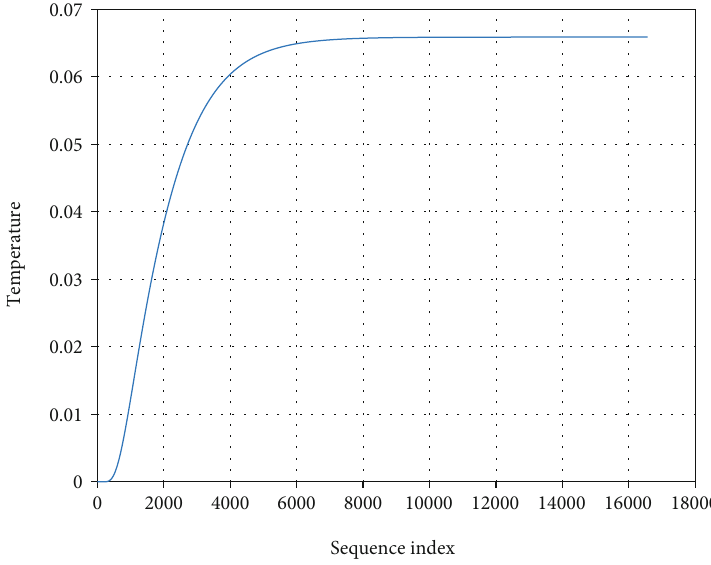
Figure 7: Sequence behavior at point 0.75.